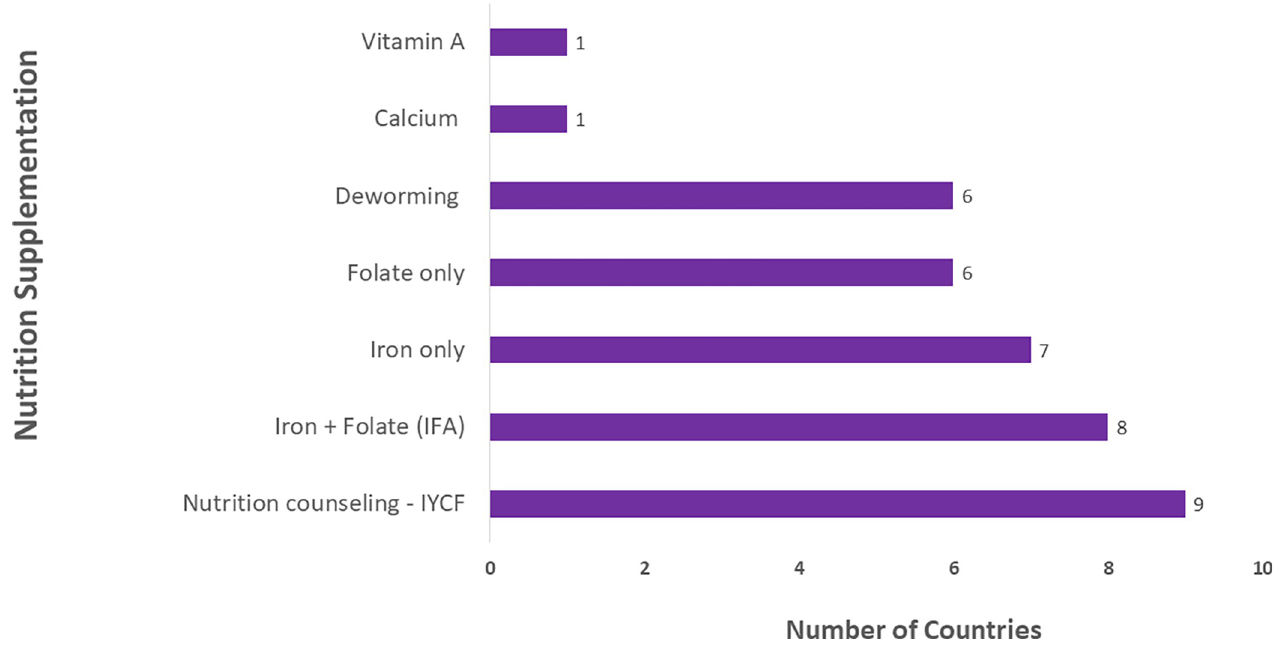
Fig 1. Nutrition supplementation and counseling.